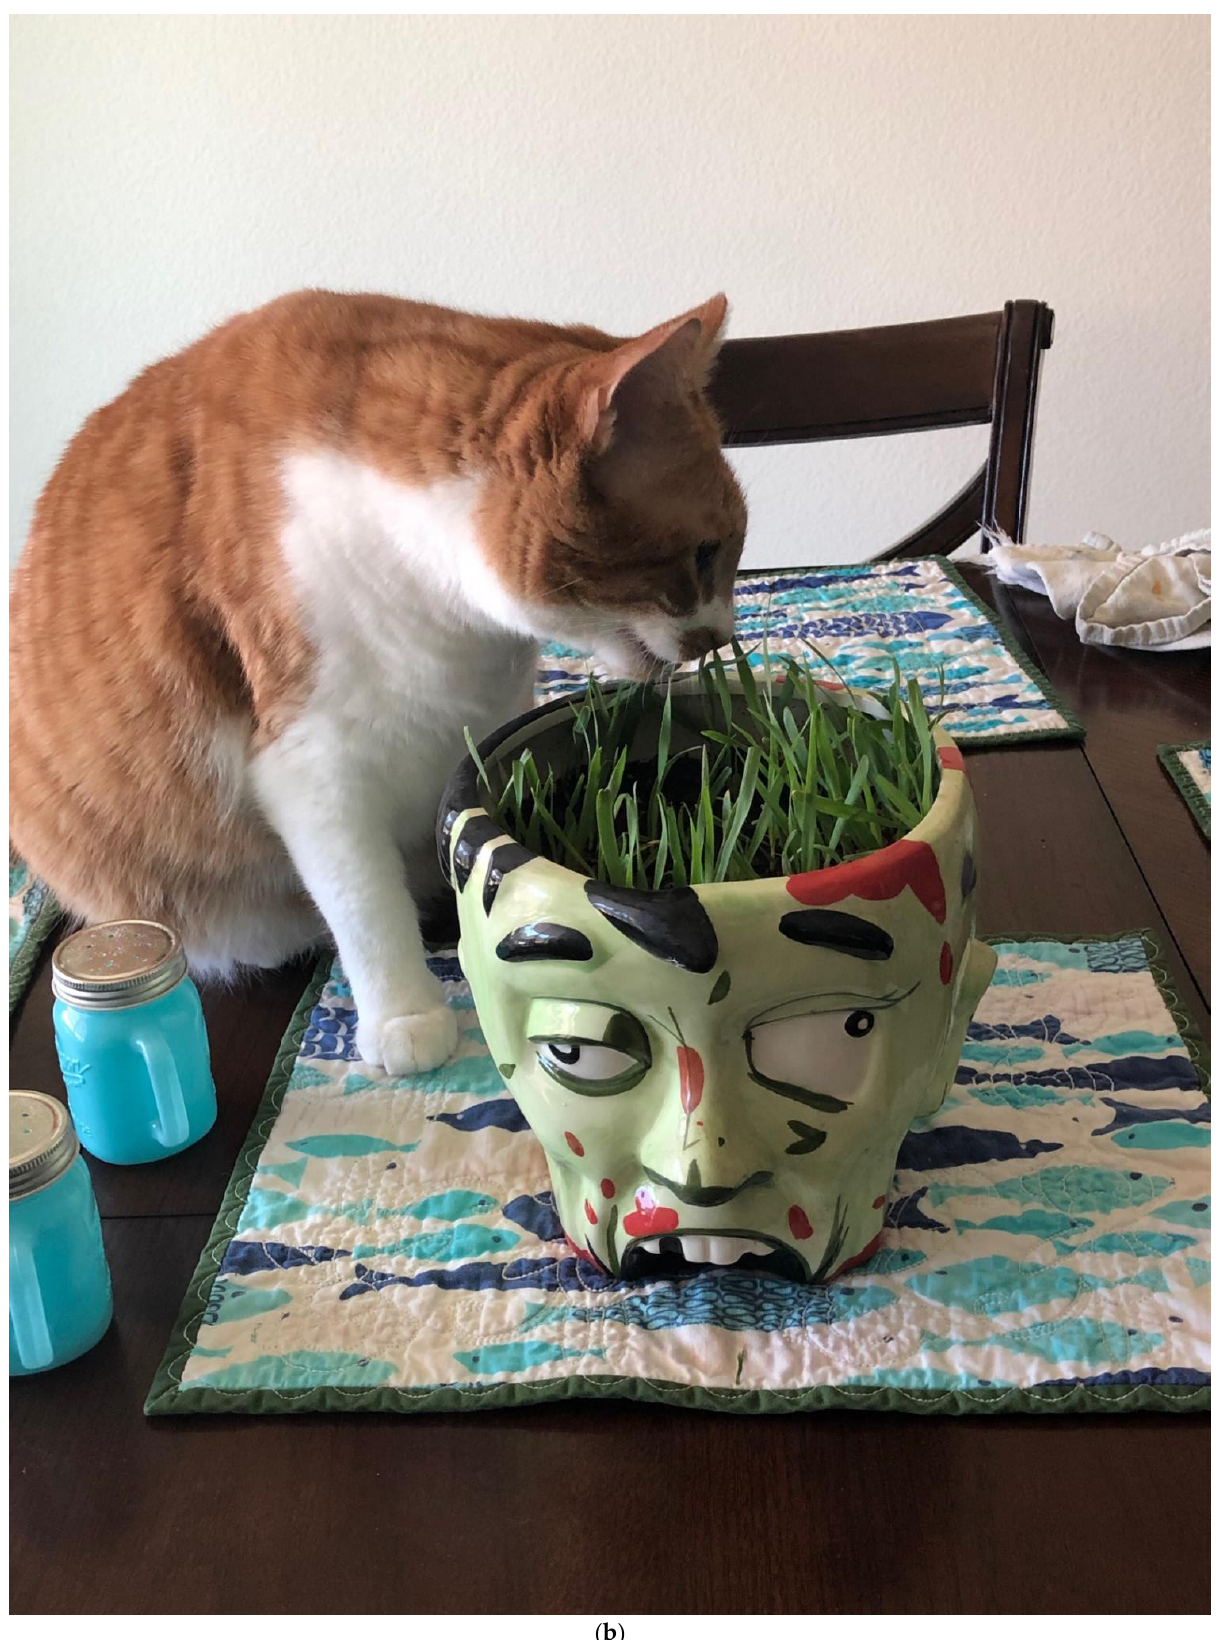
Figure 1. ( a , b ) Examples of cats eating grass inside their homes (photo credits: Erica Orcutt).